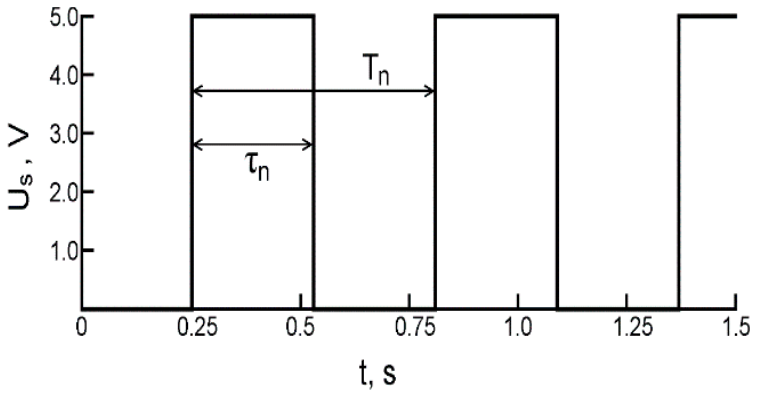
Figure 6. The sequence of control pulses on the electronic key 15.